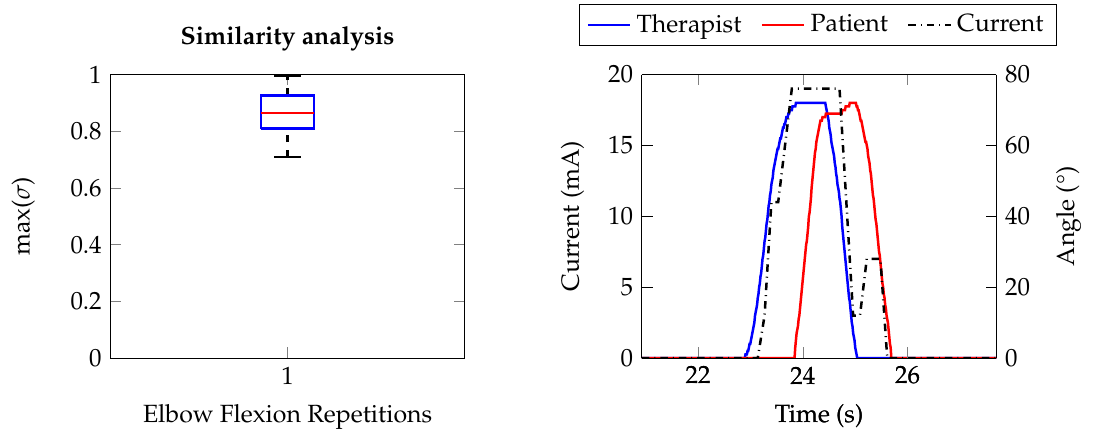
Figure 12. ( left ) Example of the stimulation application of a repetition of the Elbow Flexion (EF) movement: Blue and red are the angular signals of the therapist and patient, respectively; the dashed black line represents the FES current injected through the electrodes. ( right ) Similarity analysis using the maximum of the cross-correlation coefficient to compare the limb motion angular signals of the therapist and patient for the EF